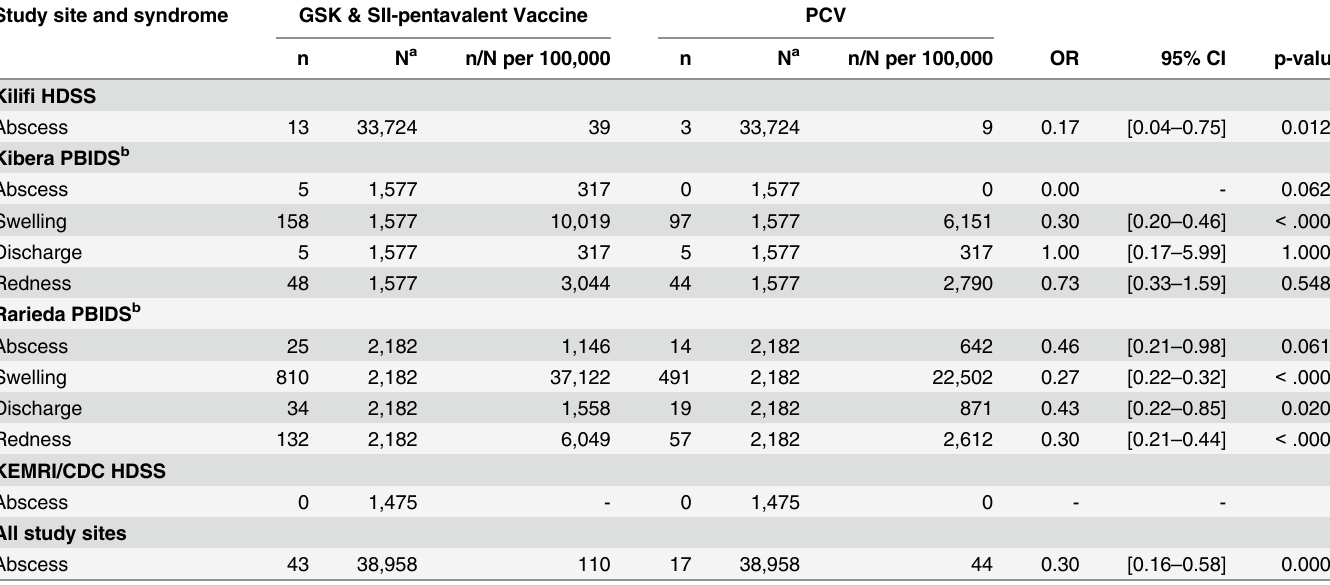
Abbreviations: CDC, Centers for Disease Control and Prevention; CI, con fi dence interval; GSK, GlaxoSmithKline; HDSS, Health and Demographic Surveillance System; PBIDS, Population-based Infectious Disease Surveillance Site; KEMRI, Kenya Medical Research Institute; OR, odds ratio; SII, Serum Institute of India; VAEIK, Vaccine Adverse Events in Kenya a Denominator is the number of vaccine doses administered. Data represent matched vaccine encounters in which the infant received both pentavalent vaccine and PCV10 at the same visit. b PBIDS data represent household- and health facility-based surveillance combined; no abscesses or related symptoms were identi fi ed at the PBIDS health facilities. The risks of abscess per 100,000 injections for the SII versus GSK pentavalent vaccines were,